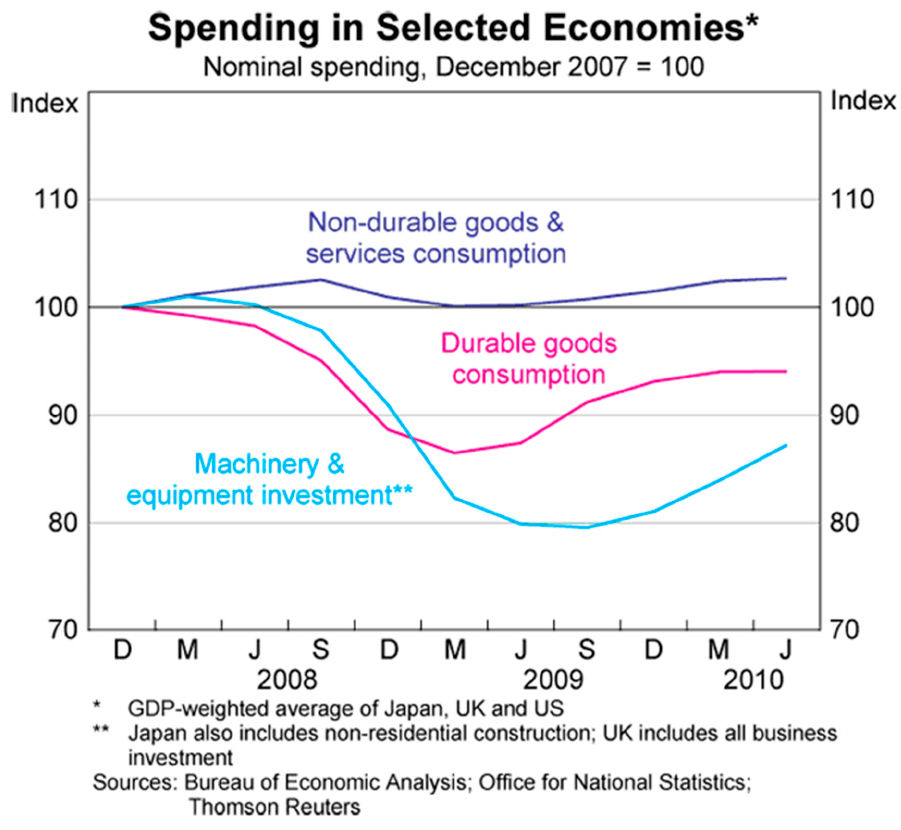
Figure 2. Spending in Selected Economies November 2018-February 2010 (Source: Cycle, Black and Cusbert, RBA Durable Goods and the Business Study,